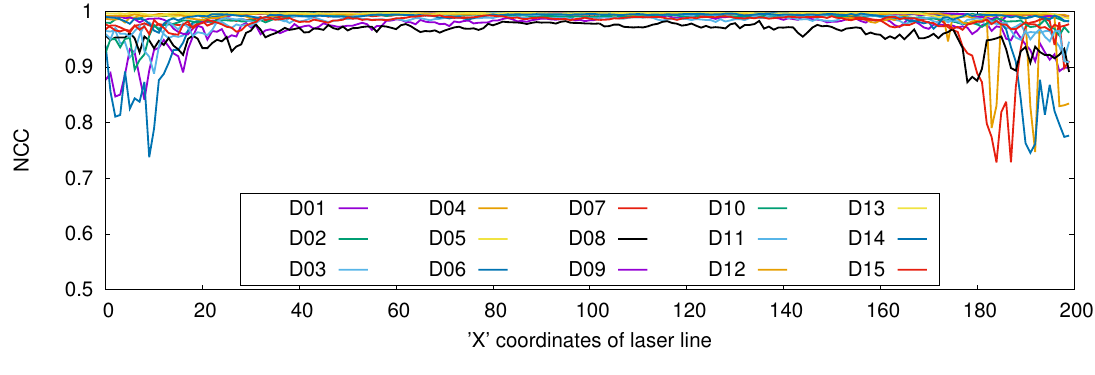
Figure 13. Normalized cross-correlation (NCC) between PCA and laser scanning across 100 frames. NCC is calculated for each point on the laser line along the X-axis separately.